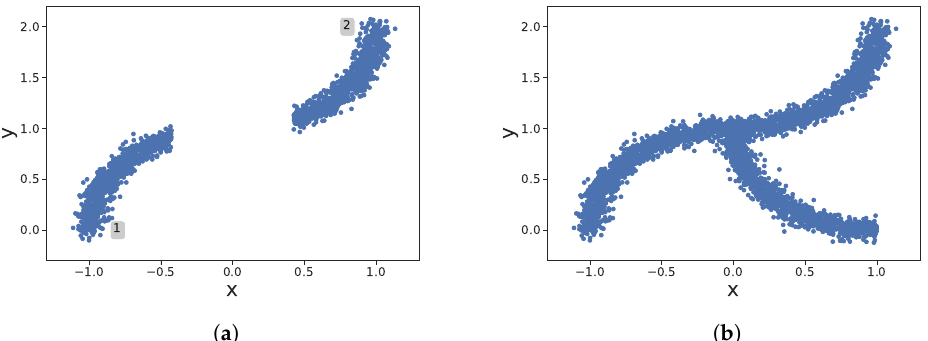
Figure 6. The T synthetic dataset. ( a ) The first 1800 samples from the T dataset. ( b ) The T